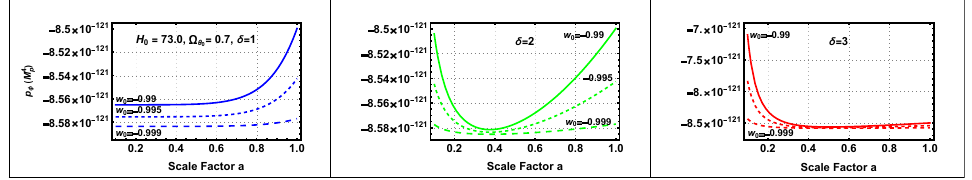
Figure 11. The evolution of the dark energy pressure for all of the cases in this study.